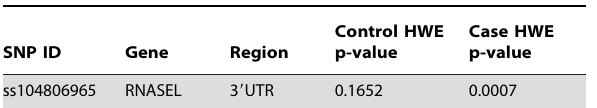
Table 2. Exact test of HWE among equine OAS1 and RNASEL